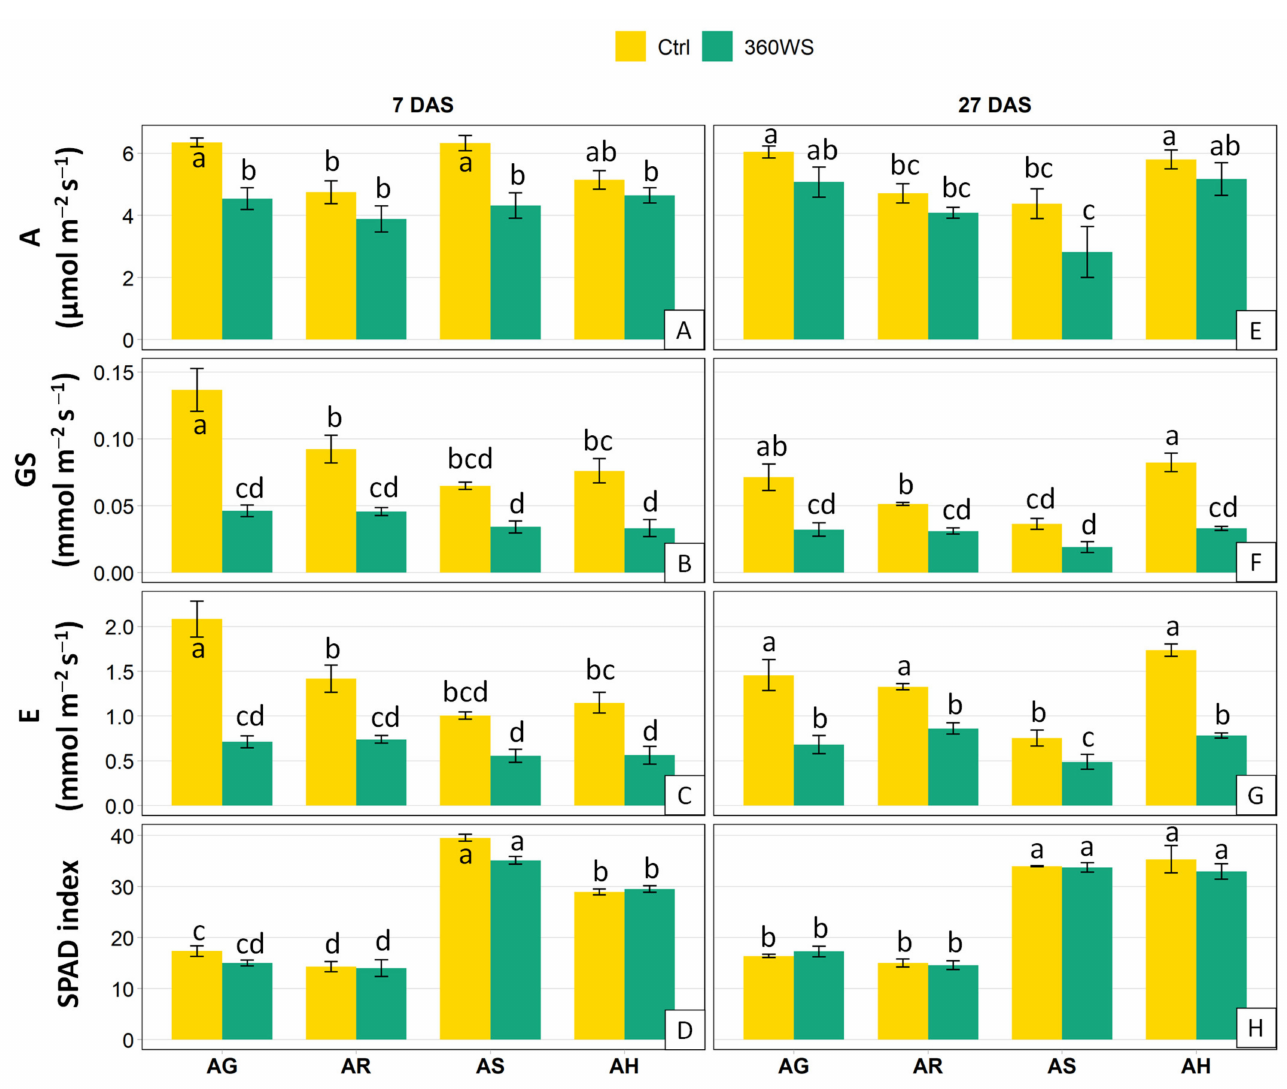
Figure 2. Photosynthetic activity ( A ), stomatal gas exchange (GS), transpiration rate ( E ) and, chlorophyll content (SPAD value) at 7 days after salt stress initiation (DAS) ( A , B , C , D , respectively) and at 27 DAS ( E , F , G , H , respectively) under control (Ctrl) and 360 mM water salinity (360 WS) in the four genotypes A. hortensis cv. green (AG), A. hortensis cv. red (AR), A. hortensis cv. scarlet (AS), and A. halimus (AH). Vertical bars indicate standard error ( n = 4). Different letters indicate significant differences at p <